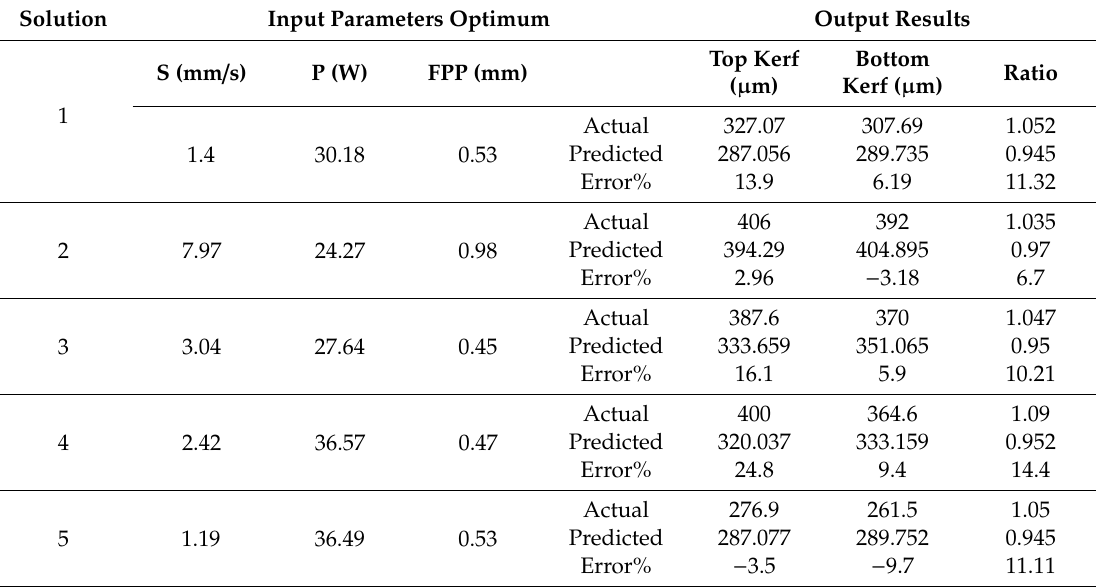
Table 9. Input and output parameters for optimum